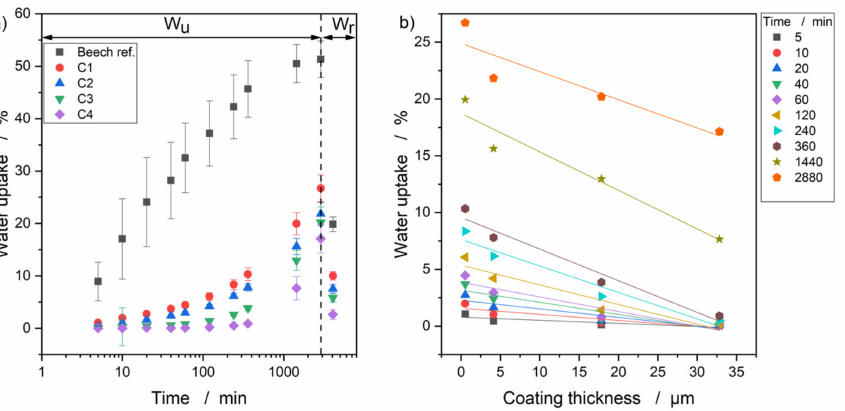
Figure 6. ( a ) Time course of water uptake ( W u ) and release ( W r ) of the coated and uncoated wood samples; ( b ) correlation of water uptake and coating thickness over the considered time